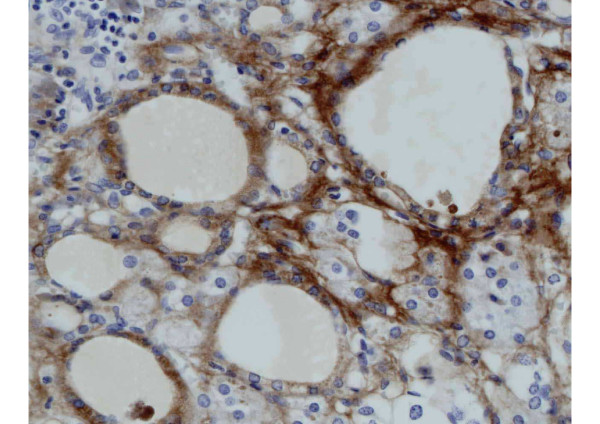
Thyroglobulin immunohistochemical stain and.